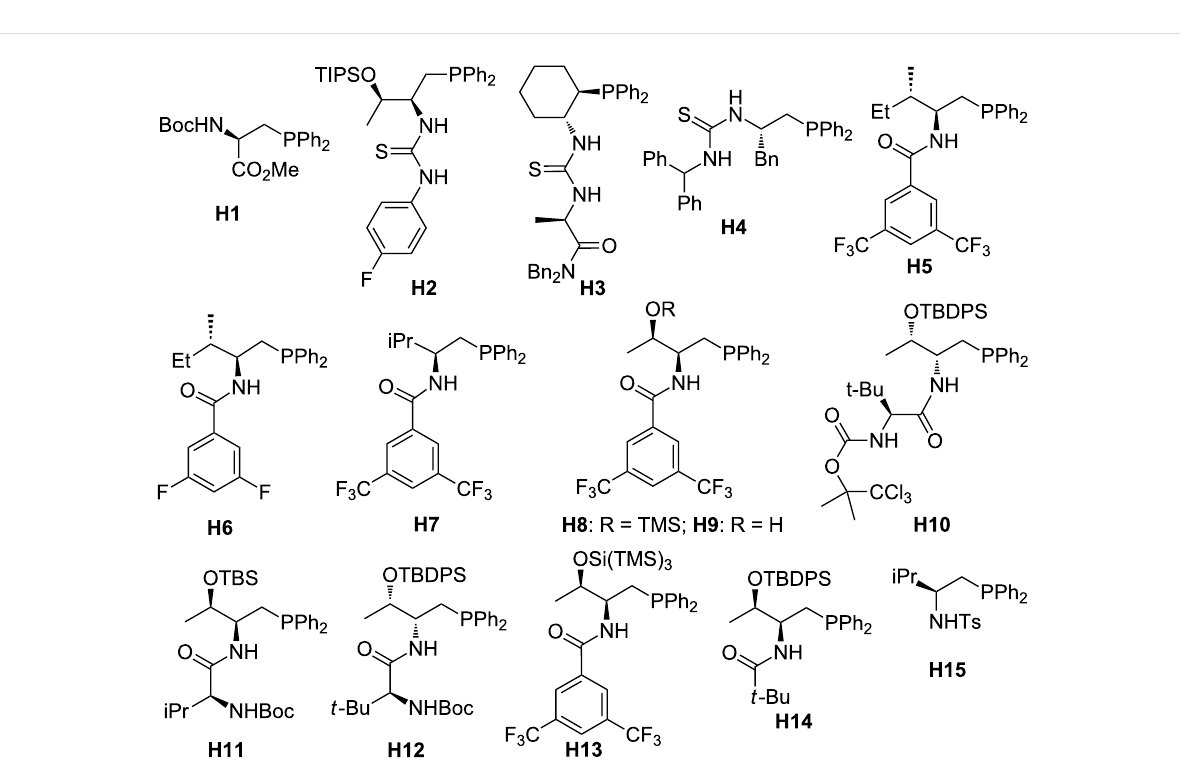
Figure 8: Multifunctional chiral phosphines based on amino acid